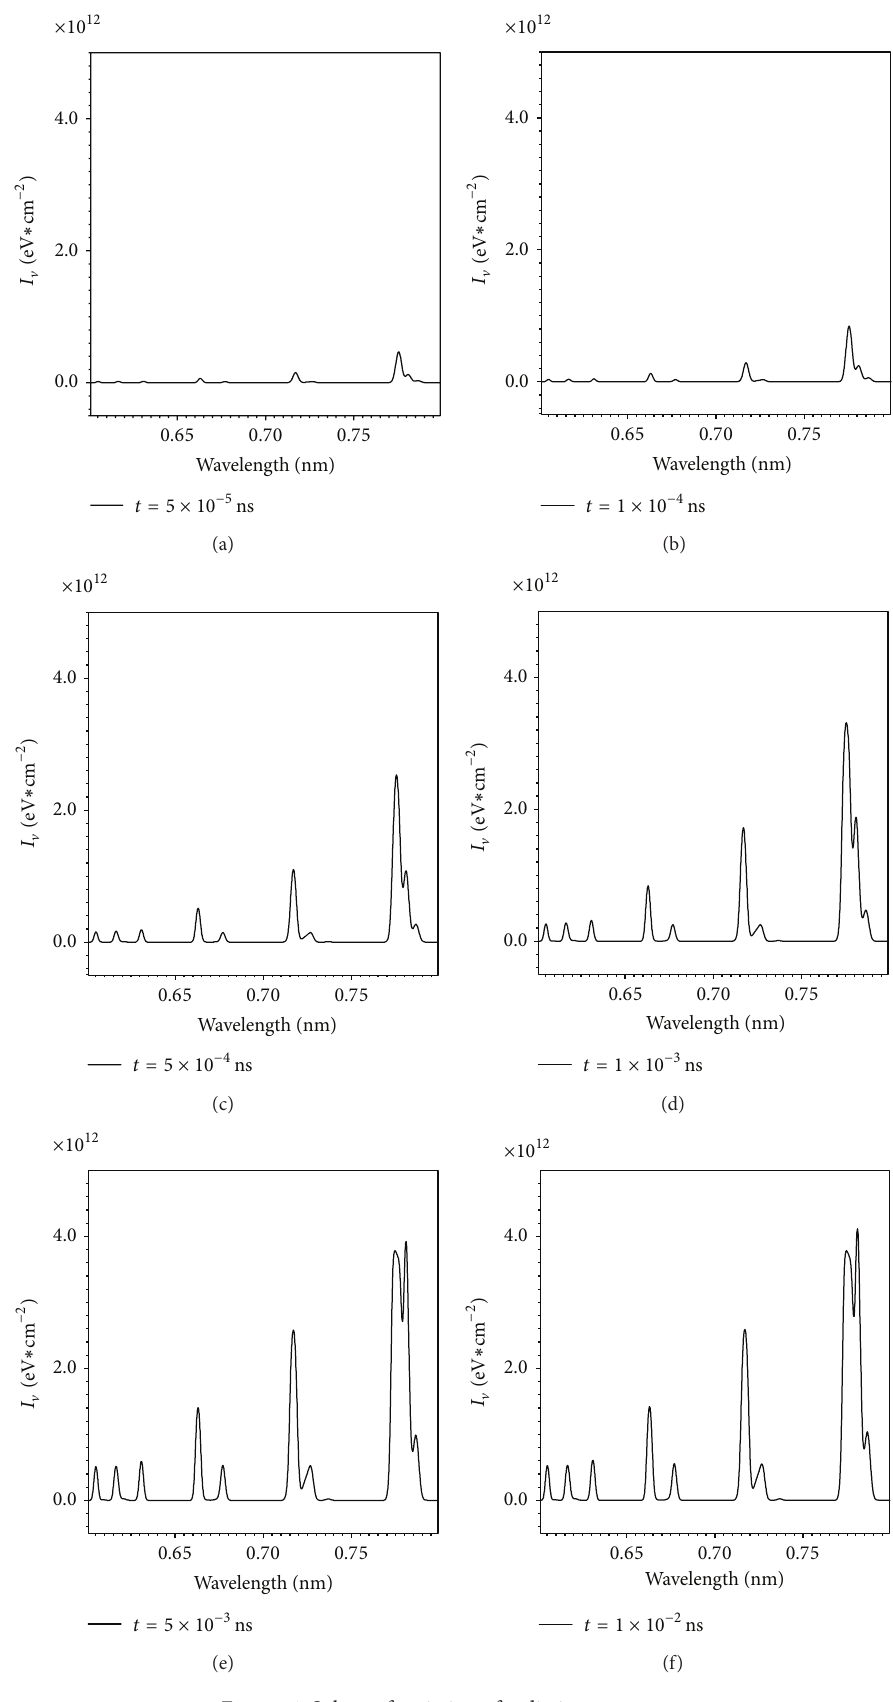
Figure 1: Subset of variation of radiation